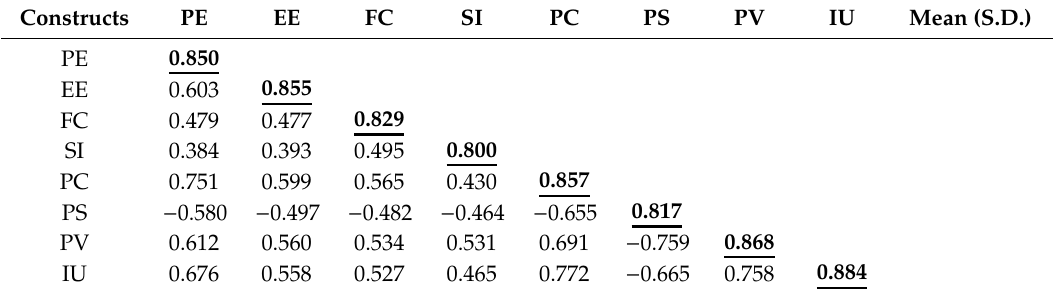
Table 3. Discriminant validity statistics of each